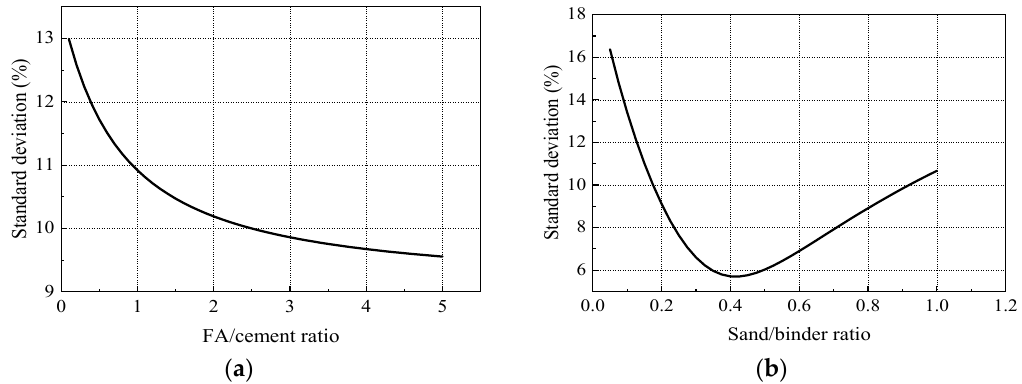
Figure 2. Particle size distribution of raw materials.